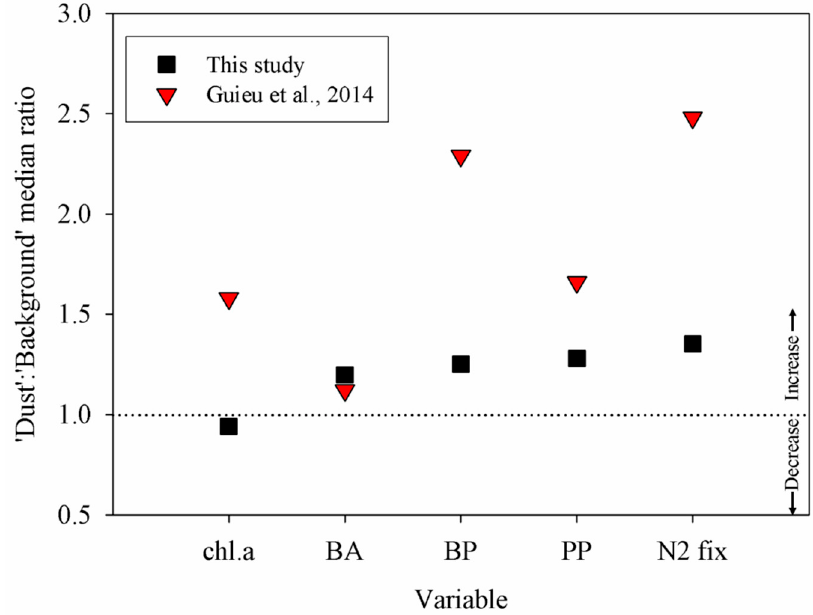
Figure 5. Summary of relative change in different variables (ratio of median value during dust events to median background conditions) in response to desert dust deposition at the coastal SEMS, 2013–2017 (in situ, black squares) and the ratio compiled by Guieu et al. [19] (field and laboratory aerosol addition bioassay and mesocosm experiments, red triangles).